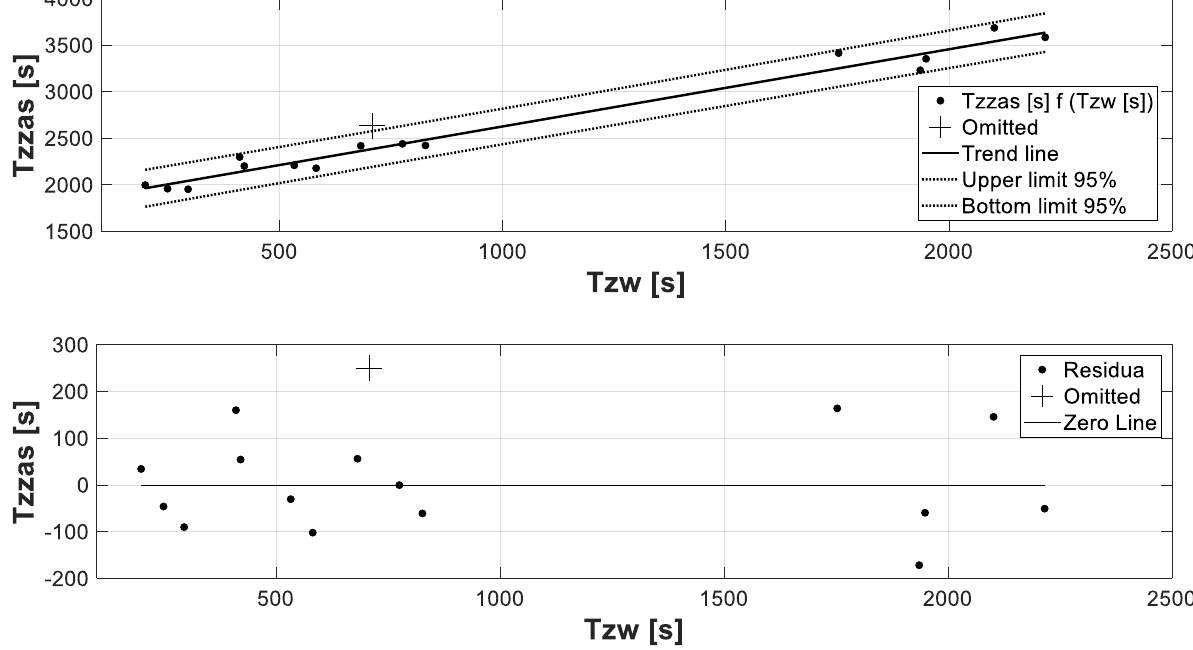
Figure 15. Relationship between the equivalent time constant of the storage tank and of the coil heat exchanger.